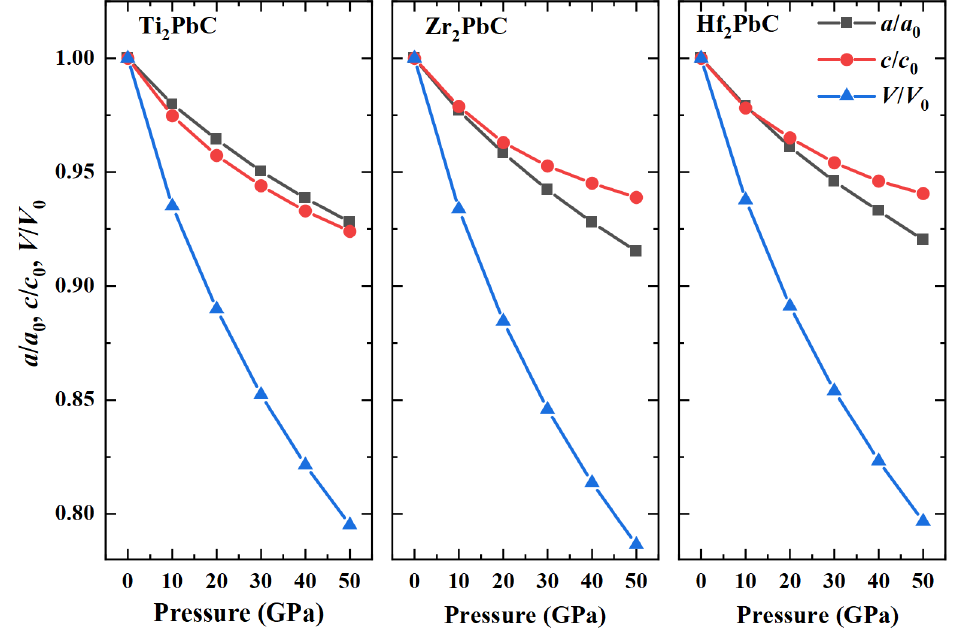
Figure 2. The pressure dependence of a/a 0 , c/c 0 and volume V/V 0 for M 2 PbC (M = Ti, Zr, Hf) MAX phase .